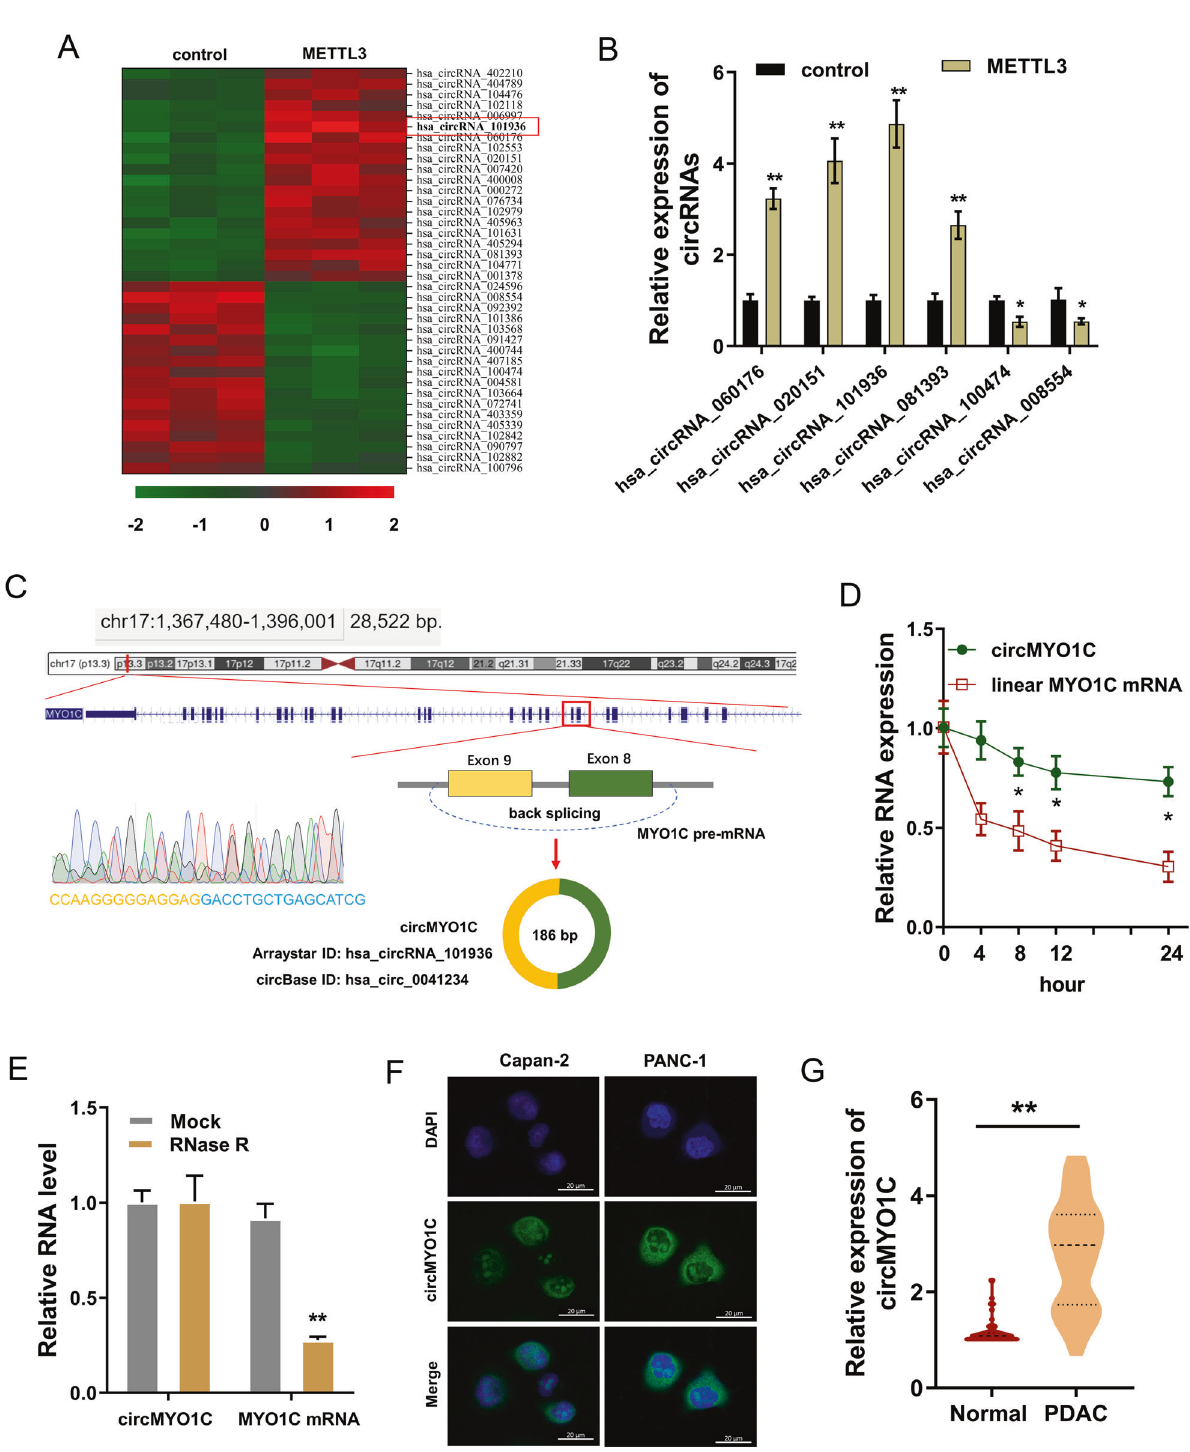
Fig. 1 circMYO1C was a METTL3-induced circRNA and upregulated in PDAC. A Heatmap of circRNA microarray showed the up or downregulated circRNAs in the METTL3 overexpression transfection versus control transfection in PANC-1 cells. B Several candidate circRNAs were quantitatively analyzed by RT-qPCR in PANC-1 cells. C The genomic loci of the MYO1C gene and generation of circMYO1C. Sanger sequencing con fi rmed the head-to-hail splicing site of circMYO1C. D Actinomycin D administration assay was performed on PANC-1 cells and then an expression of circMYO1C and linear MYO1C mRNA was detected using RT-qPCR. E The RNase R digestion was performed on PANC-1 cells and then an expression of circMYO1C and linear MYO1C mRNA was detected using RT-qPCR. F RNA fl uorescence in situ hybridization (RNA-FISH) using circMYO1C probes showed the distribution of circMYO1C in PDAC cells. G The expression of circMYO1C in the clinical specimens of PDAC patients. * p < 0.05 and ** p < 0.01.